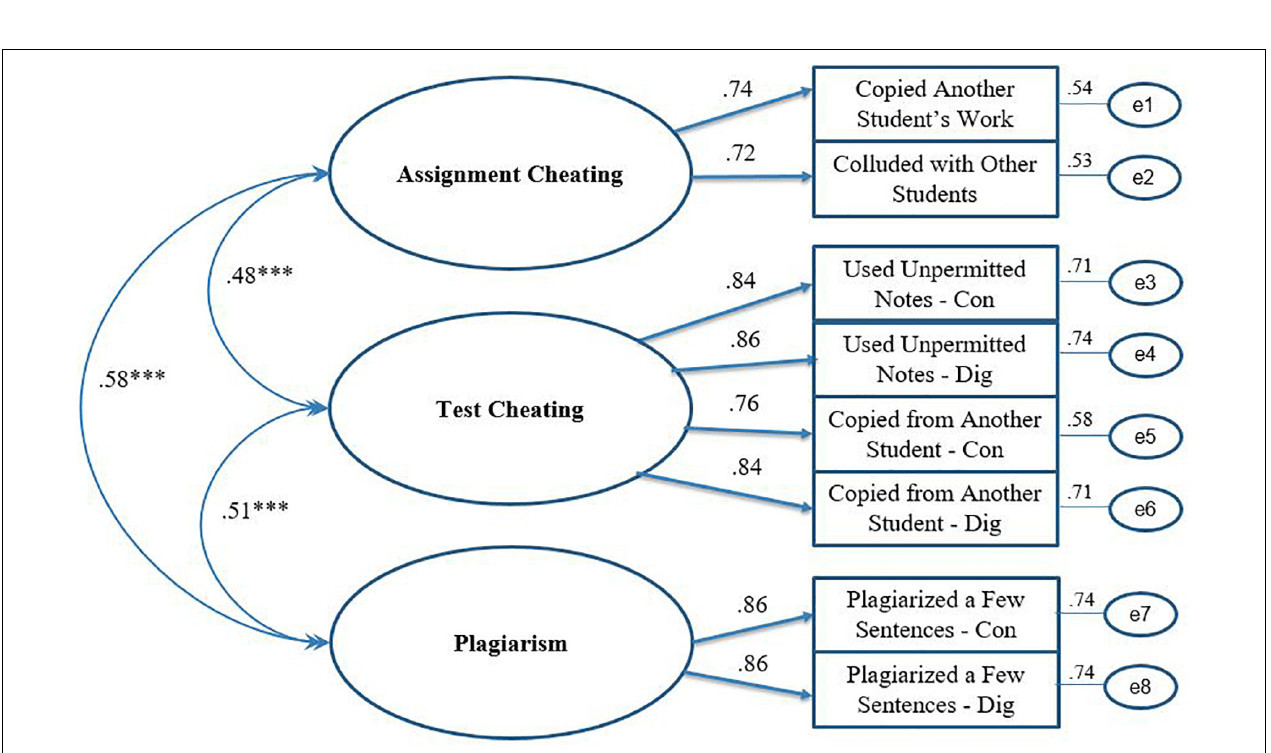
FIGURE 2 | Standardized estimates of the three-factor measurement model of participants’ perceptions related to academic integrity policies and peer norms. Model 1.1 – Full Sample. ∗∗∗ p < 0.001.